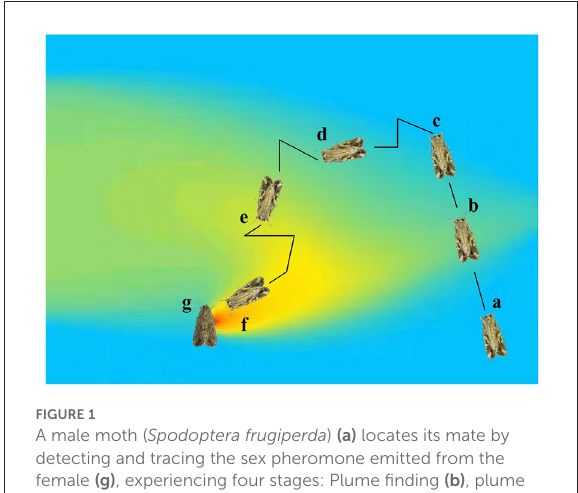
FIGURE1 A male moth ( Spodoptera frugiperda ) (a) locates its mate by detecting and tracing the sex pheromone emitted from the female (g) , experiencing four stages: Plume finding (b) , plume reacquiring (d) after detaching from the odor coverage (c) , plume traversal (e) , and source declaration (f)